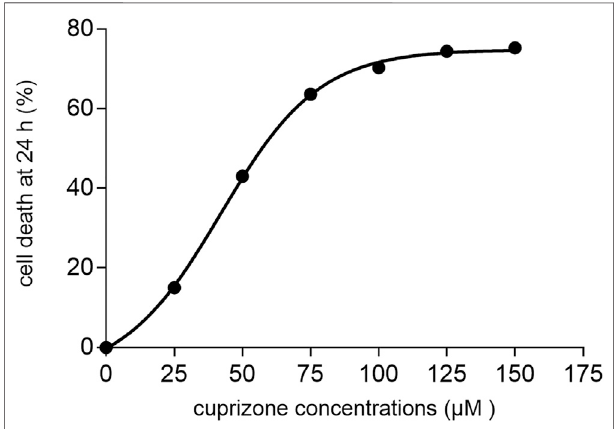
Frontiers in Pharmacology |